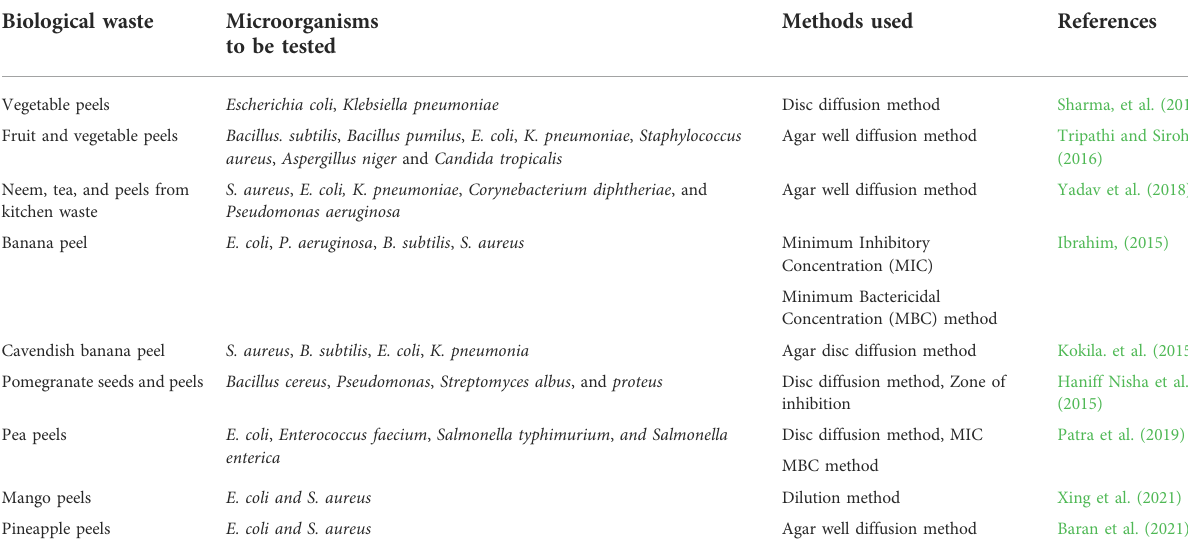
TABLE 2 Antimicrobial activities of silver nanoparticles synthesized using different fruit and vegetable waste peels.